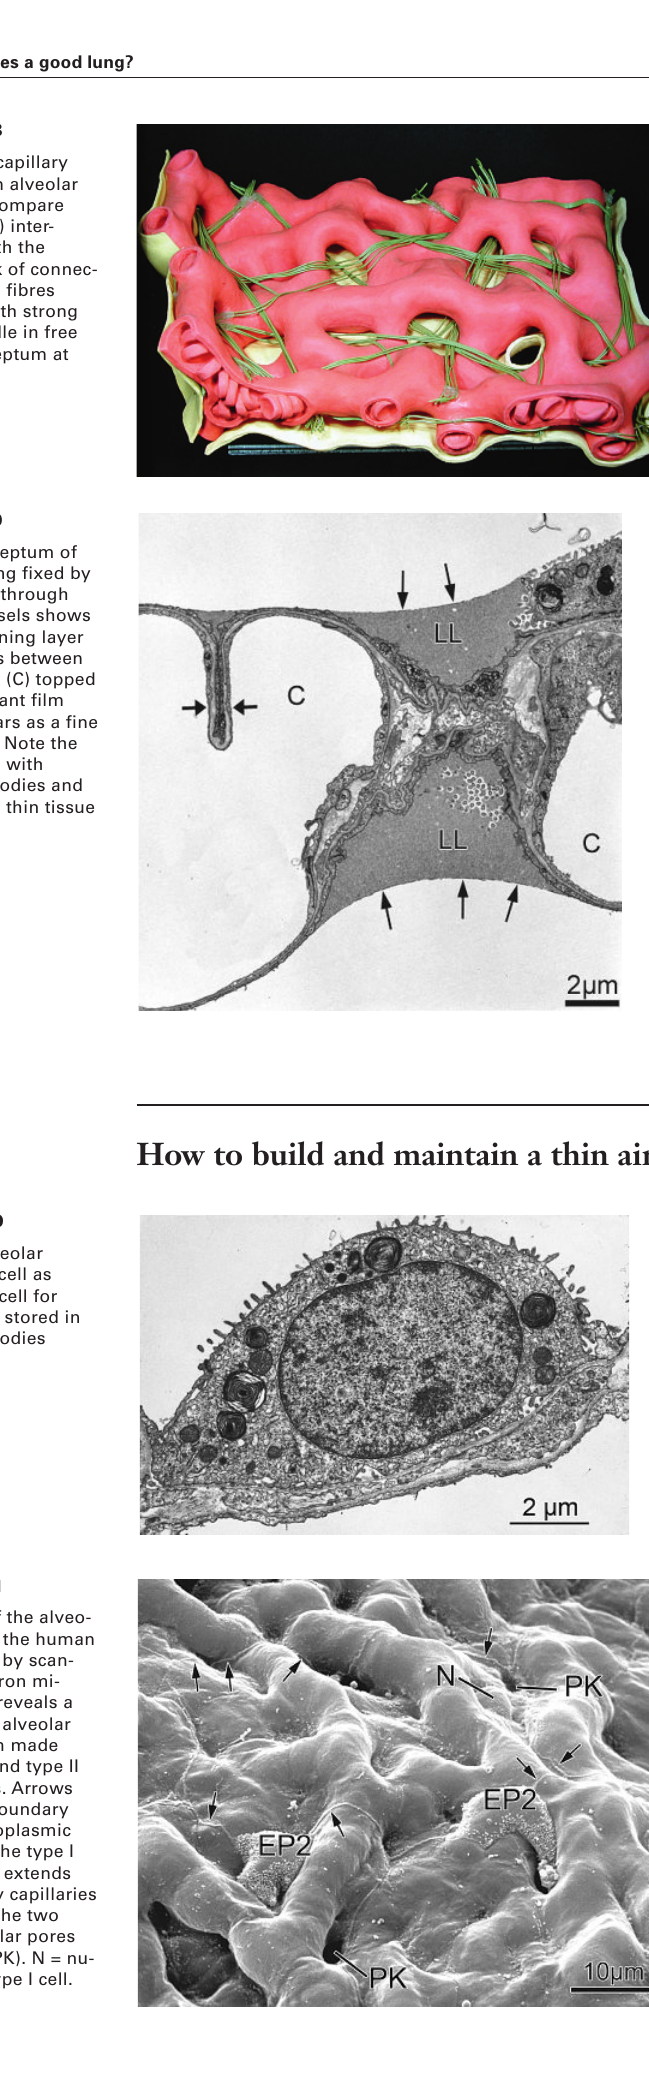
Surface of the alveo- lar wall in the human lung seen by scan- ning electron mi- croscopy reveals a mosaic of alveolar epithelium made of type I and type II (EP2) cells. Arrows indicate boundary of the cytoplasmic leaflet of the type I cell which extends over many capillaries (C). Note the two interalveolar pores of Kohn (PK). N = nu- cleus of type I